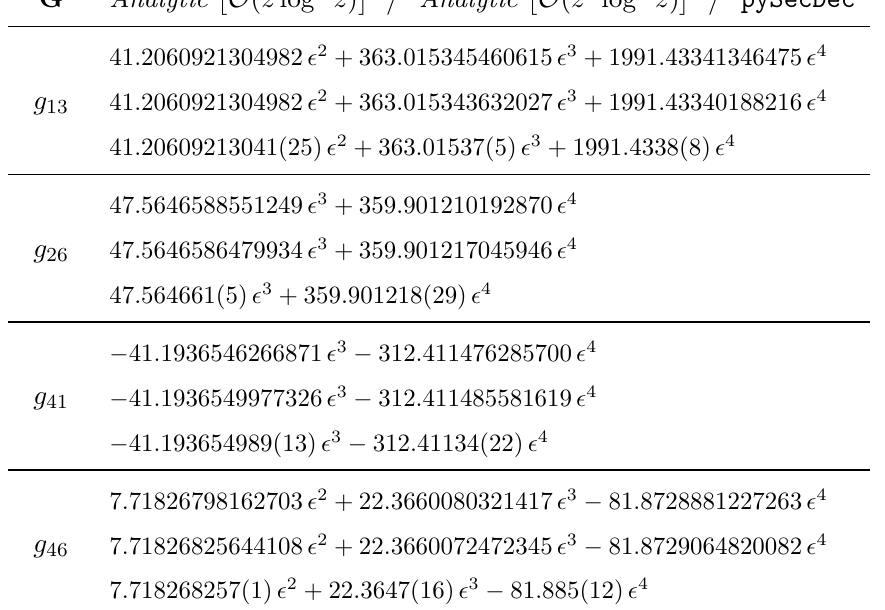
) = ( − 5 , − 2 , 10 − 3 , 4) GeV 2 , m 2 W ‘